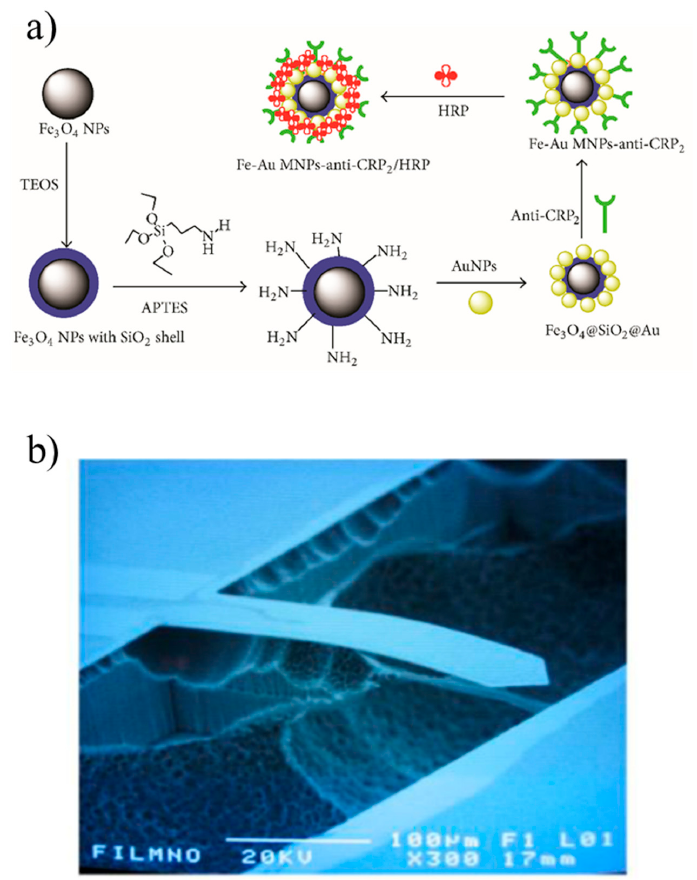
Figure 4. ( a ) Preparation of the Fe 3 O 4 -Au magnetic nanoparticles coated with anti-CRP and HRP ([104], licensed under CC BY 3.0); ( b ) SEM image of the microcantilever fabricated in [111] (licensed under CC BY